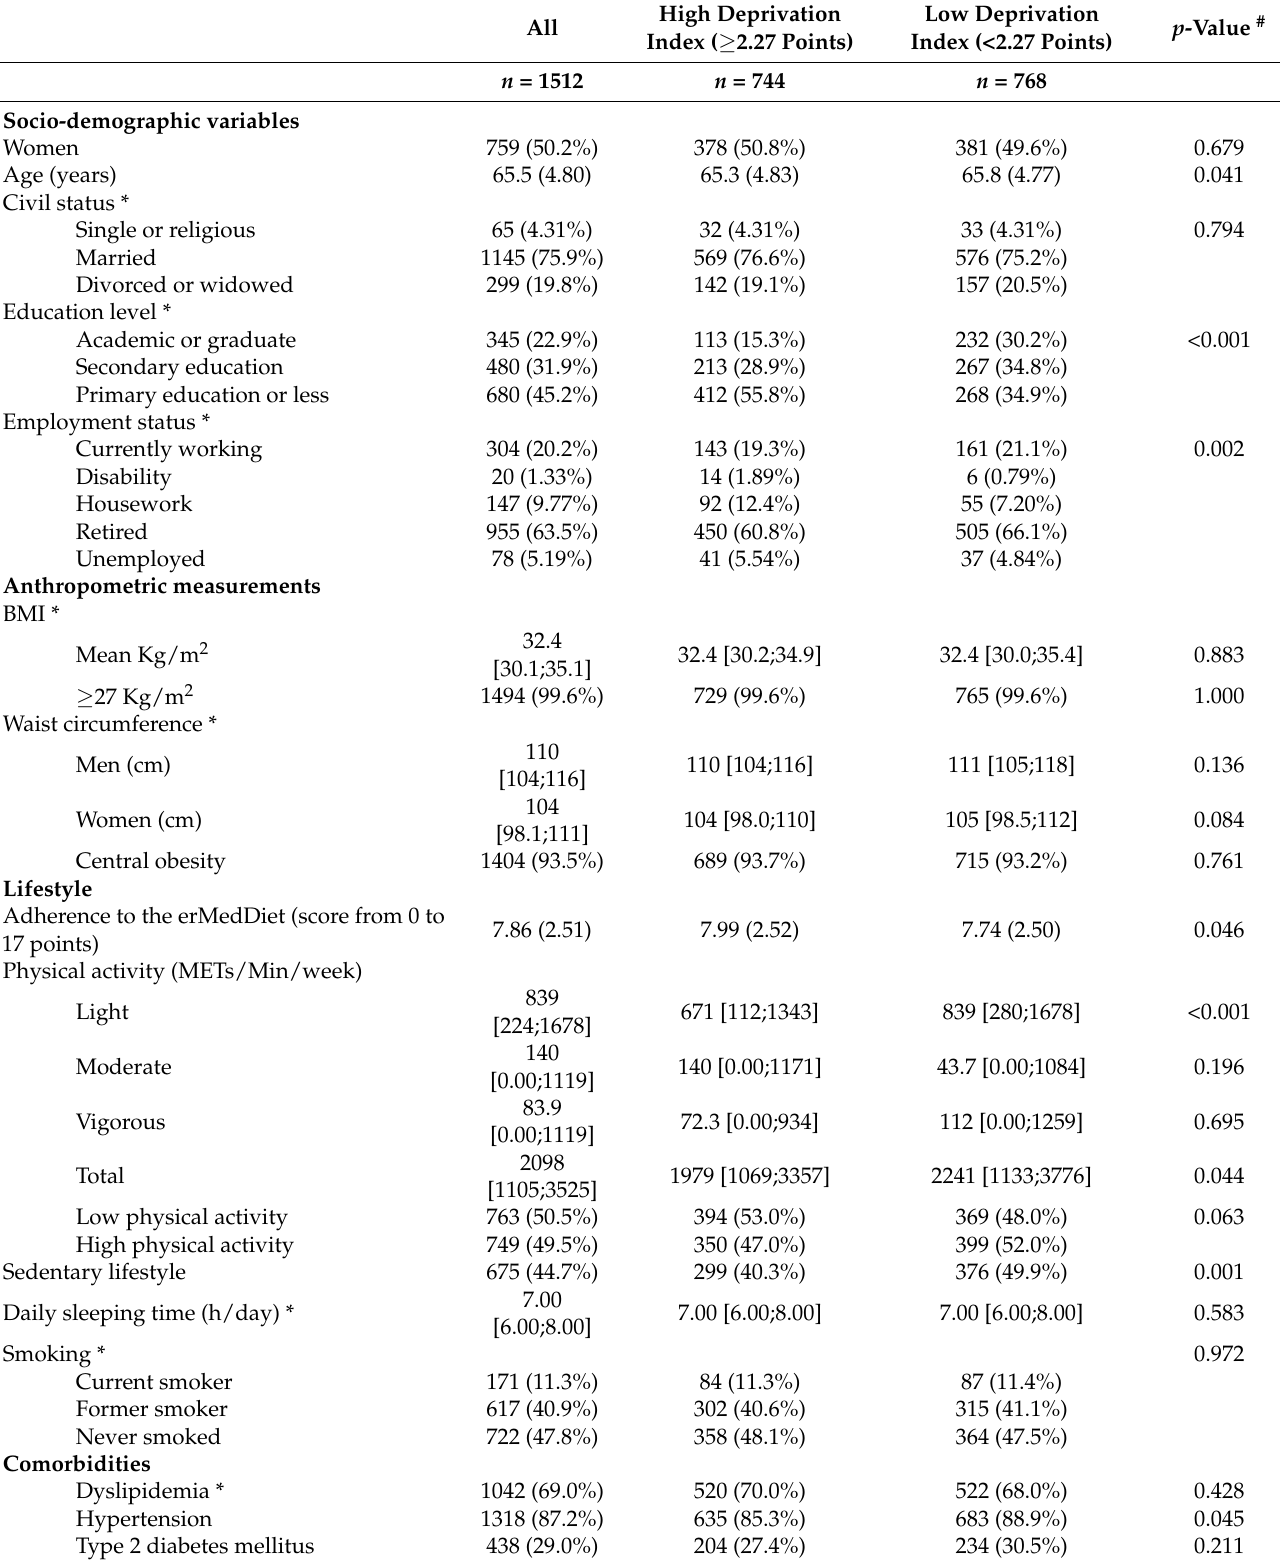
Table 1. General characteristics of participants according to composed socioeconomic index